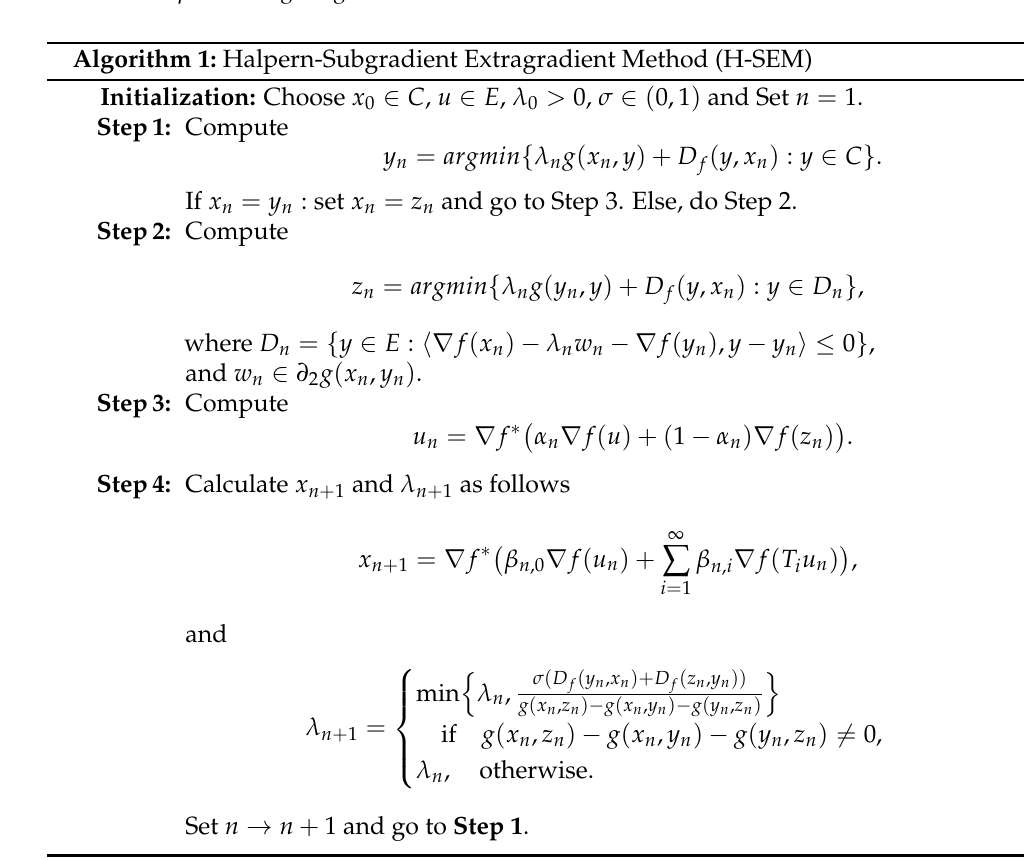
Algorithm 1: Halpern-Subgradient Extragradient Method